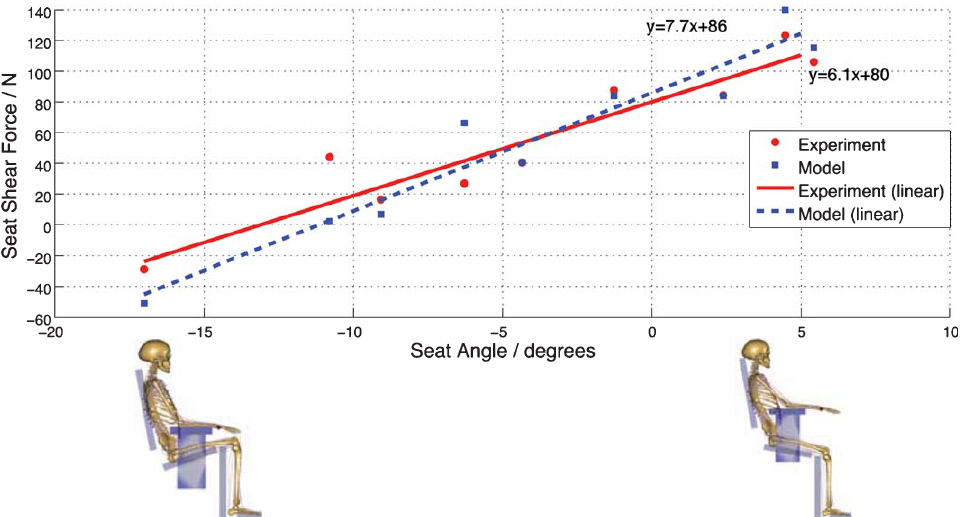
Fig. 4. The effect on the seat shear force when the seat angle is changed. The data show clear correspondence and similar trends can be observed as